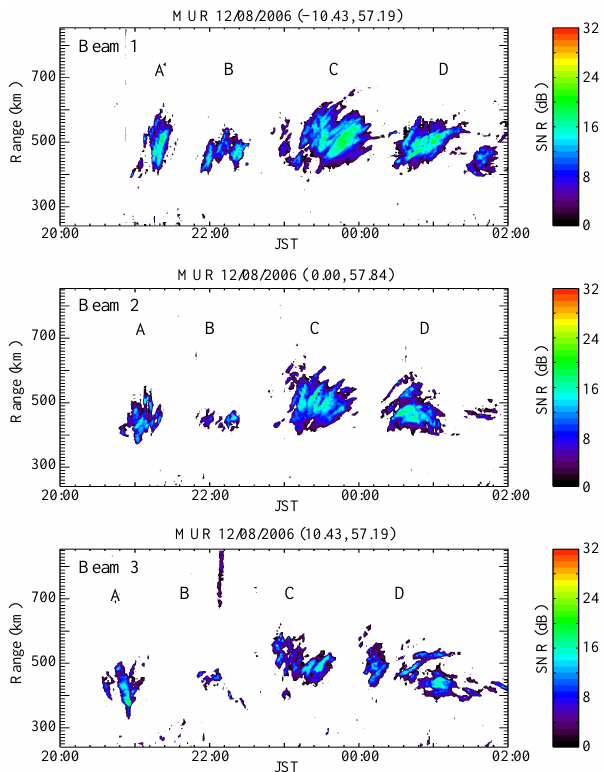
Fig. 4. Echo power observed on 12 June 2006 in the RTI format (JST=UT+9h). Upper, middle, and lower panel show the data from beams 1, 2, and 3,